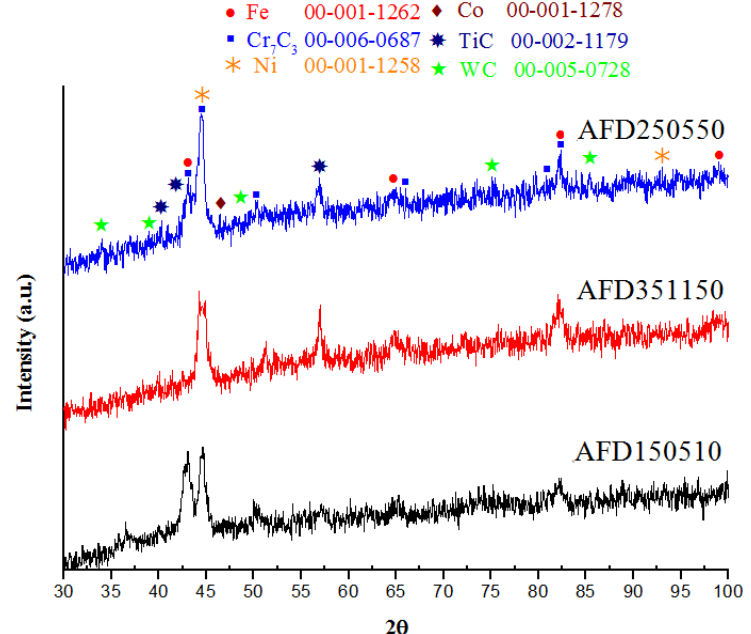
Figure 6. X ‐ ray diffraction (XRD) analysis of surface of coated samples (AFD150510, AFD351150, AFD250550).